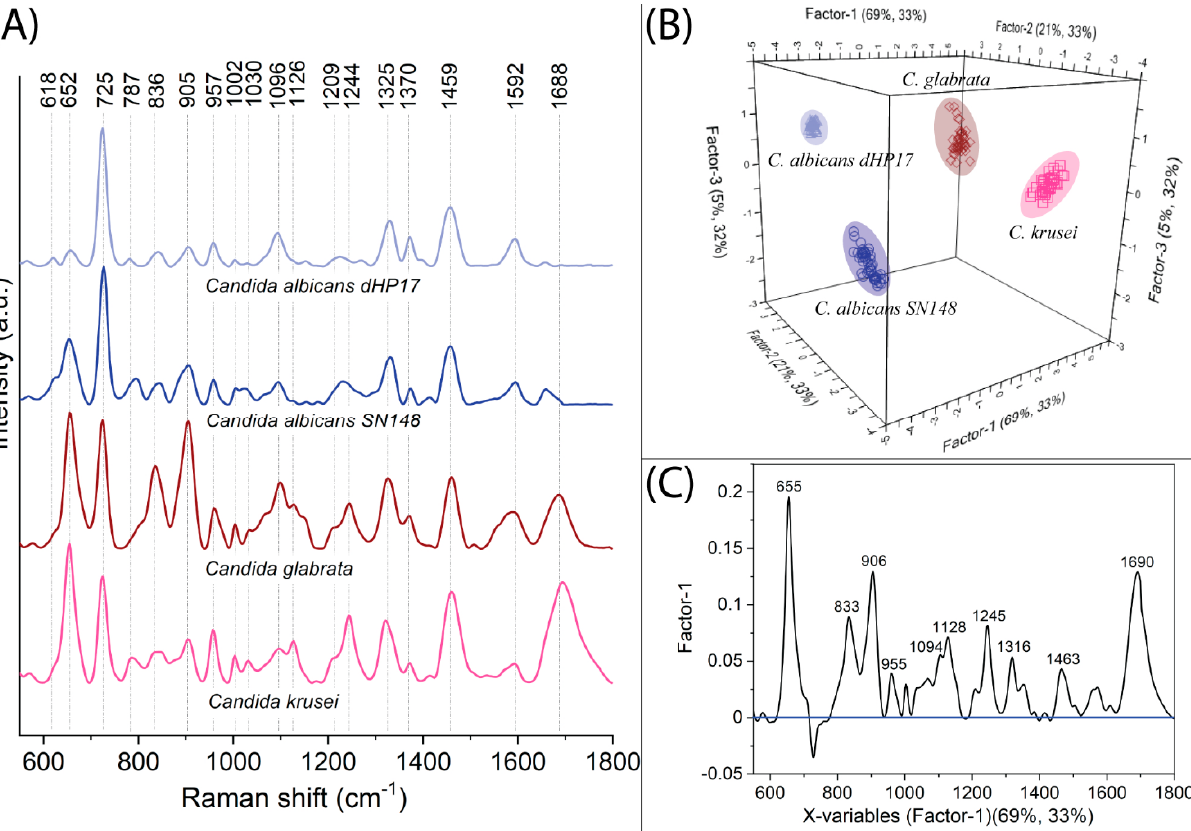
Figure 2. The SERS spectra ( A ) and PLSR results in the form of ( B ) 3D score plots and ( C ) X − loadings plots calculated for Candida spp. Table 1. The tentative assignments for the most prominent bands of bacteria, Candida spp. and Trichomonas vaginalis analyzed in the present study. Compounds typical for a specific group of mi- croorganisms are bolded. Ranges of spectral bands of different bacteria species are distinguished by symbols: a for Lactobacillus spp., b for Bifidobacterium spp., c for pathogens grown in MRS agar, d for pathogens on RCM agar, e for pathogens on TSA agar, and f for pathogens on chocolate agar.